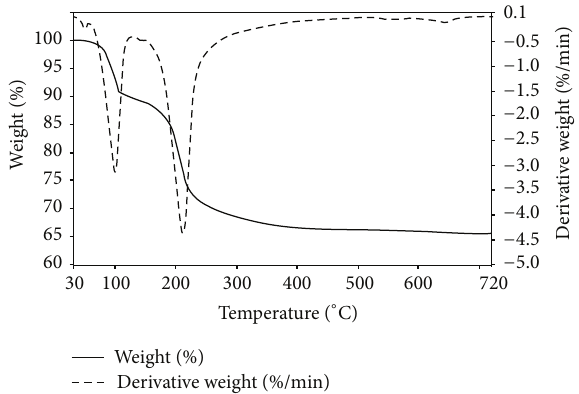
Figure 6: TG and DTG analyses of admontite mineral.